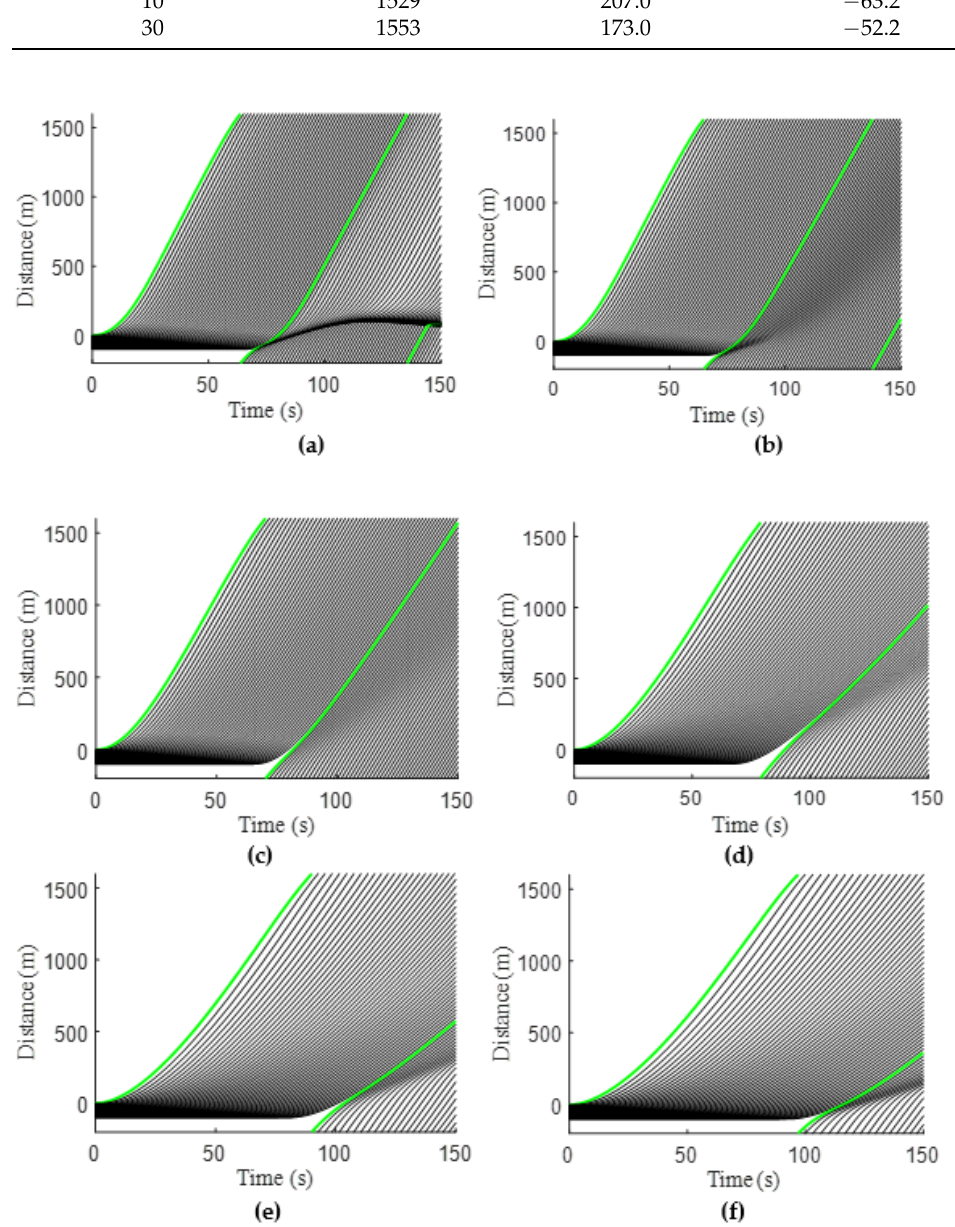
Figure 9. Time–space vehicle trajectories for the proposed model over an 1800 m circular road: ( a ) a = 0.5 m; ( b ) a = 0.6 m; ( c ) a = 1 m; ( d ) a = 1.5 m; ( e ) a = 2 m; ( f ) a = 2.2 m. The colored line shows the trajectory of the first vehicle.